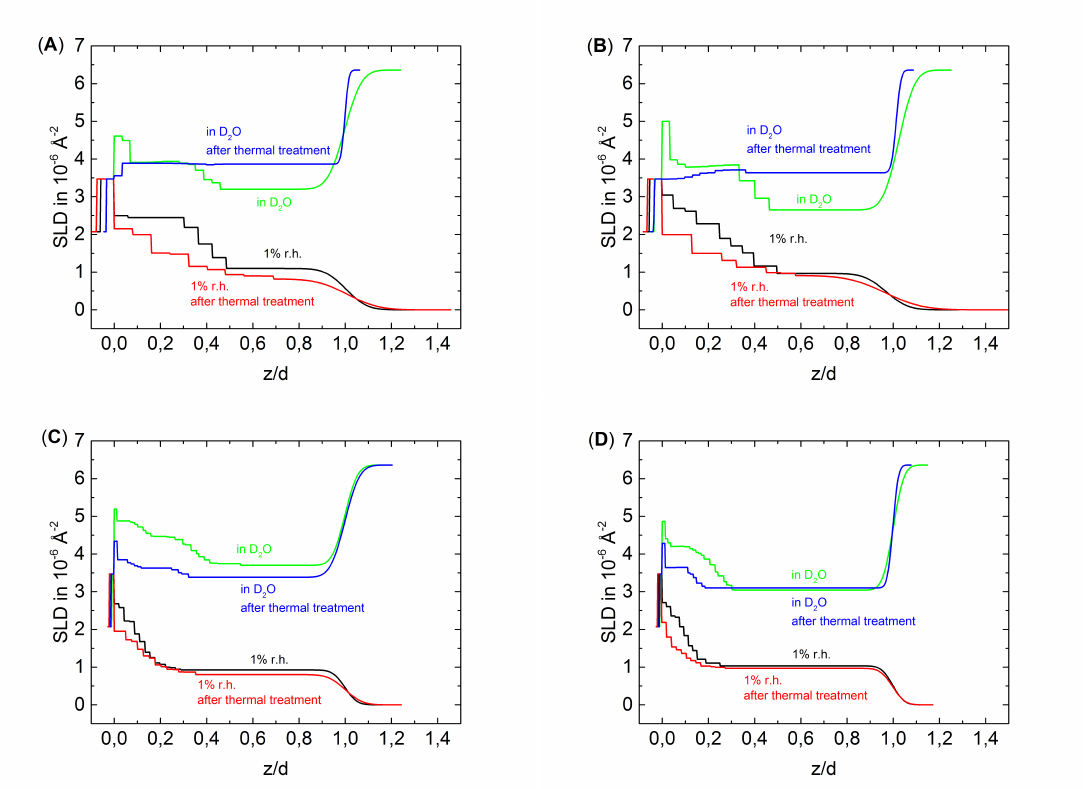
Figure 4. SLD profiles normalized to the total thickness d of D6H4 ( A ); D6H4.5 ( B ); D6H12 ( C ) and D6H12.5 ( D